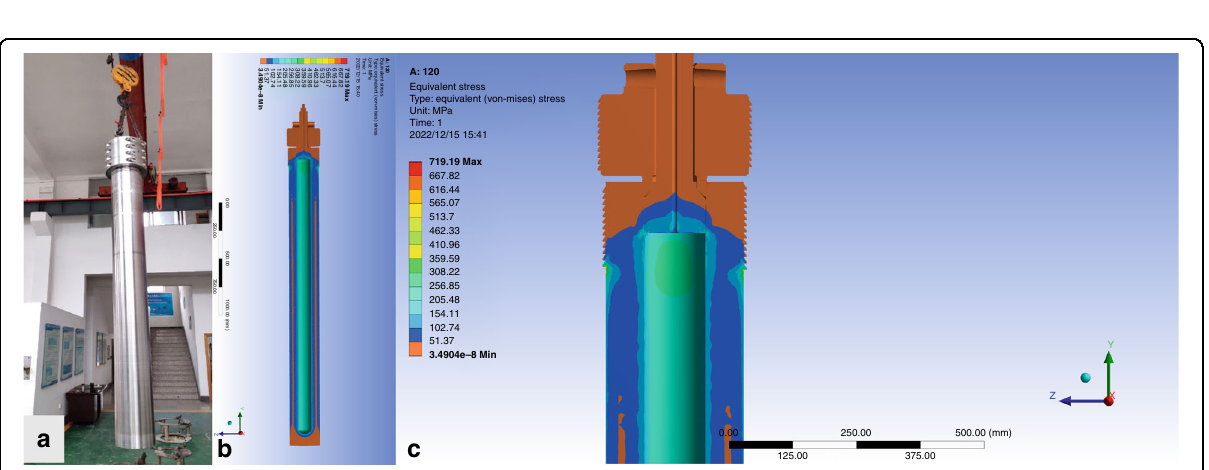
Fig. 6 The stress strain simulation analysis of large autoclave for large KTP crystal growth. a Autoclave with effective internal dimensions of Φ 120 mm diameter × 2.4 m high. Its safe long-term service temperature is less than 650 °C and its pressure is less than 300 MPa. Simulation of the autoclave ( b ) and the seal part ( c ) is completely under compression